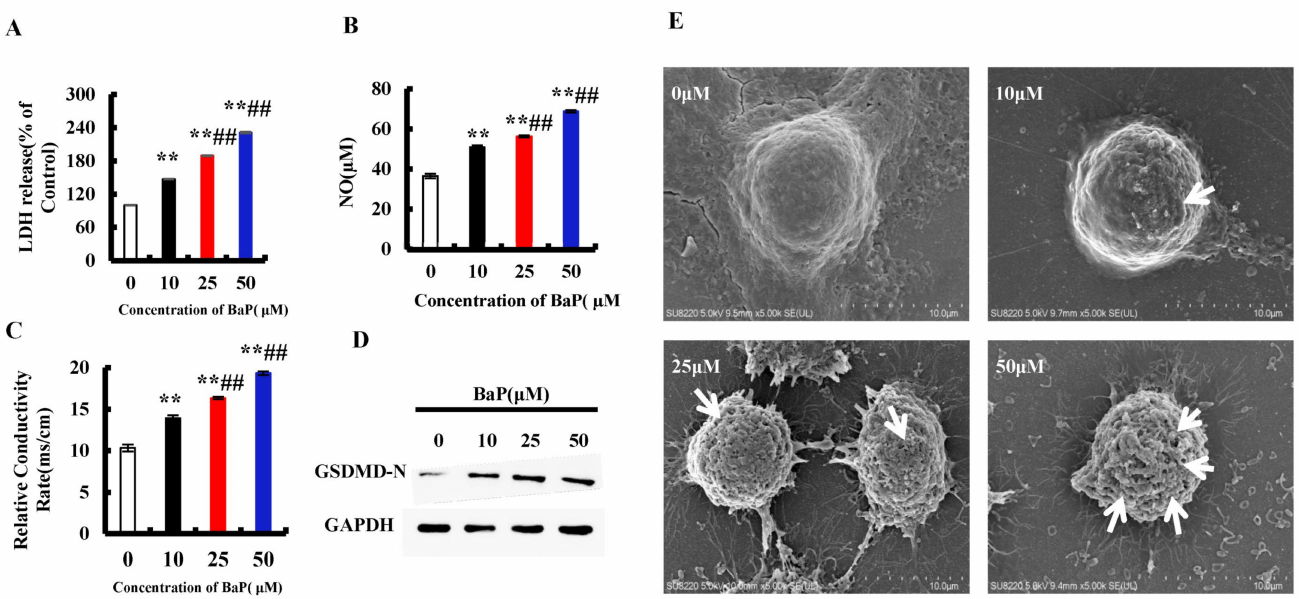
Figure 2. BaP induced pyroptotic hepatocyte damage in HL-7702 cells. LDH ( A ), NO ( B ), and electrical conductivity ( C ) were detected ** p < 0.01 compared with control, ## p < 0.01 compared with 10 µ M BaP. Western blot image of protein expression acquired by Chemical XRS Imaging System ( D ). Scanning electron microscope observation of membrane pores; white arrows indicate the membrane pore ( E